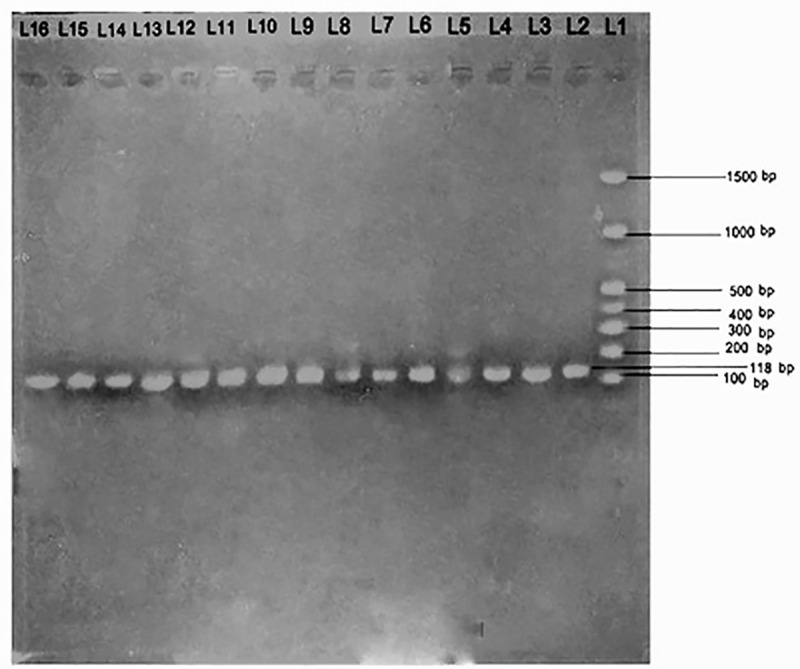
Agarose gel electrophoresis of amplified SEN virus H-gene DNA.Bands showing the amplified SEN virus-H gene (118 bp) are shown in lanes L2–L15. DNA molecular weight markers (100–1500 bp) are present in lane L1.